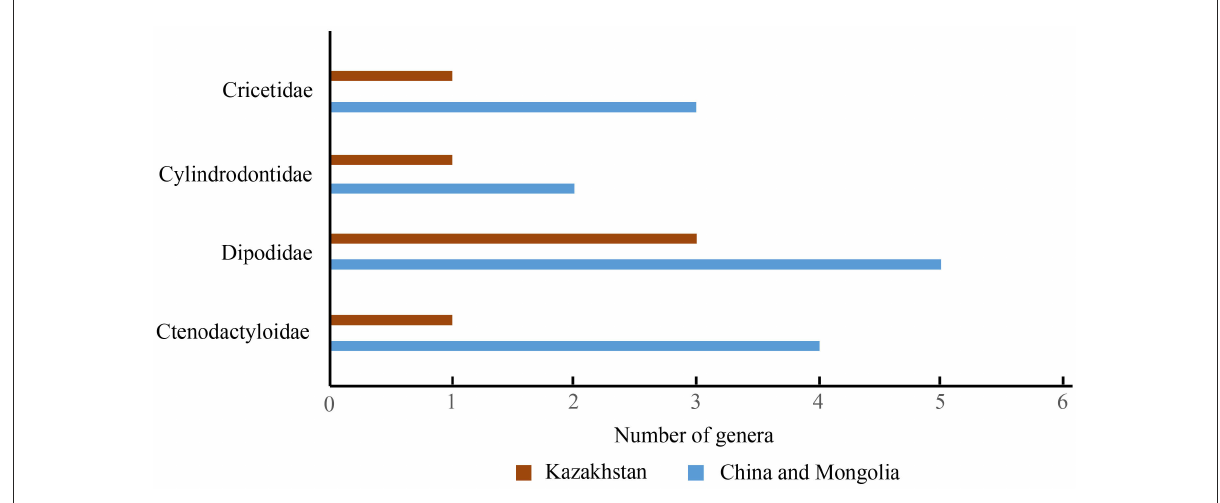
FIGURE6 Diagram of the Ergilian rodent compositions in China and Mongolia in East Asia, and Kazakhstan in Central Asia.